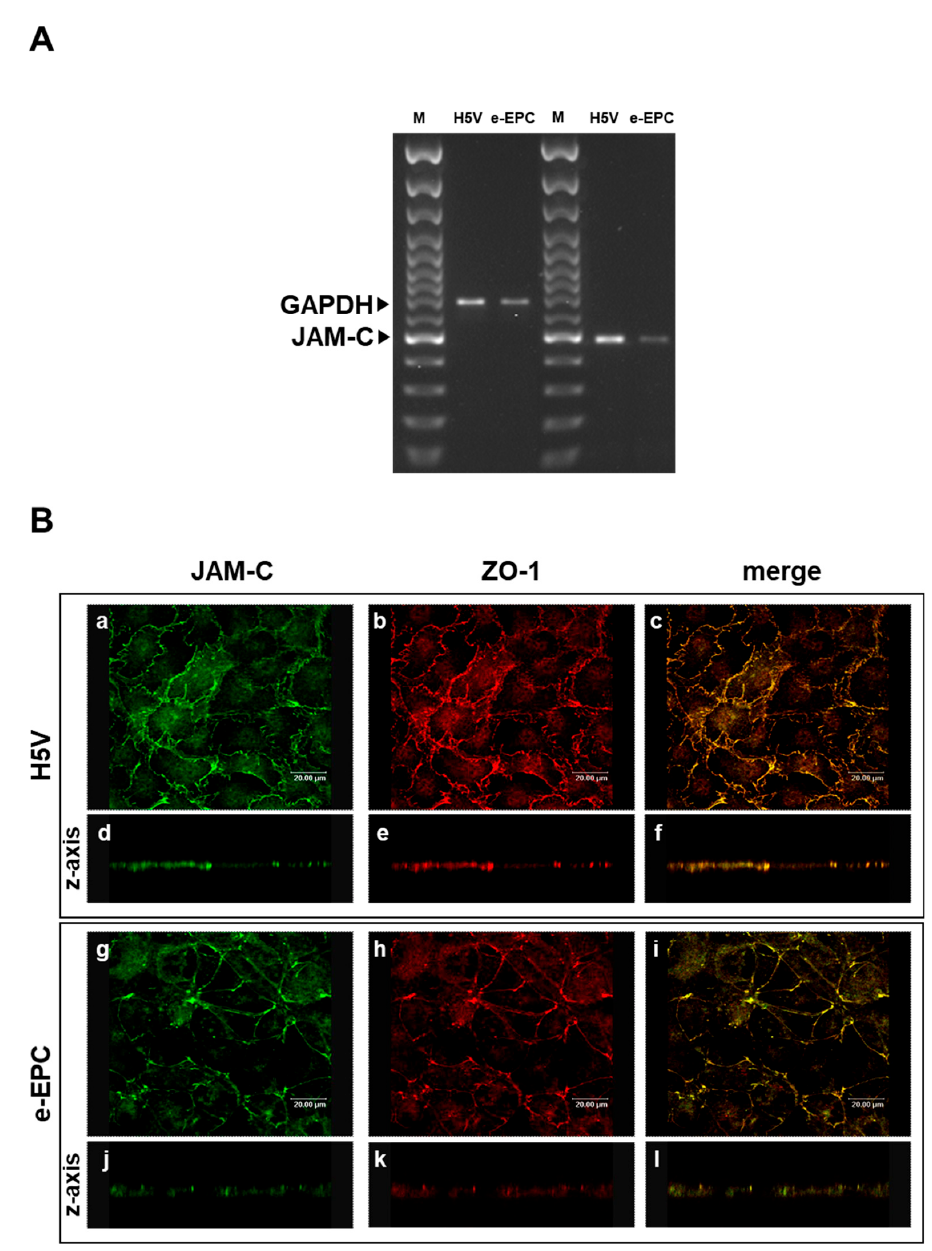
(Figure 1B: b, c, h, i). Images acquired on the z-axis of the cell monolayer confirmed protein localization of JAM-C at the cell junctional regions (Figure 1B: d, e, f, j, k, l). To test whether e-EPCs and endothelial cells interacted in a homophilic or heterophilic manner [26,34], the expression of JAM-B, a reported counter-receptor of JAM-C, was investigated. Using RT- PCR, we found that JAM-A, but not JAM-B, was expressed by the e-EPCs (Supplementary file 1A). Moreover, we found via FACS analysis that the e-EPCs also did not express β 2-integrin, another described receptor of JAM-C (Supplementary file 1B). Thus, based on these findings, we concluded that e-EPCs interact via JAM-C in a homophilic way in trans-orientation.